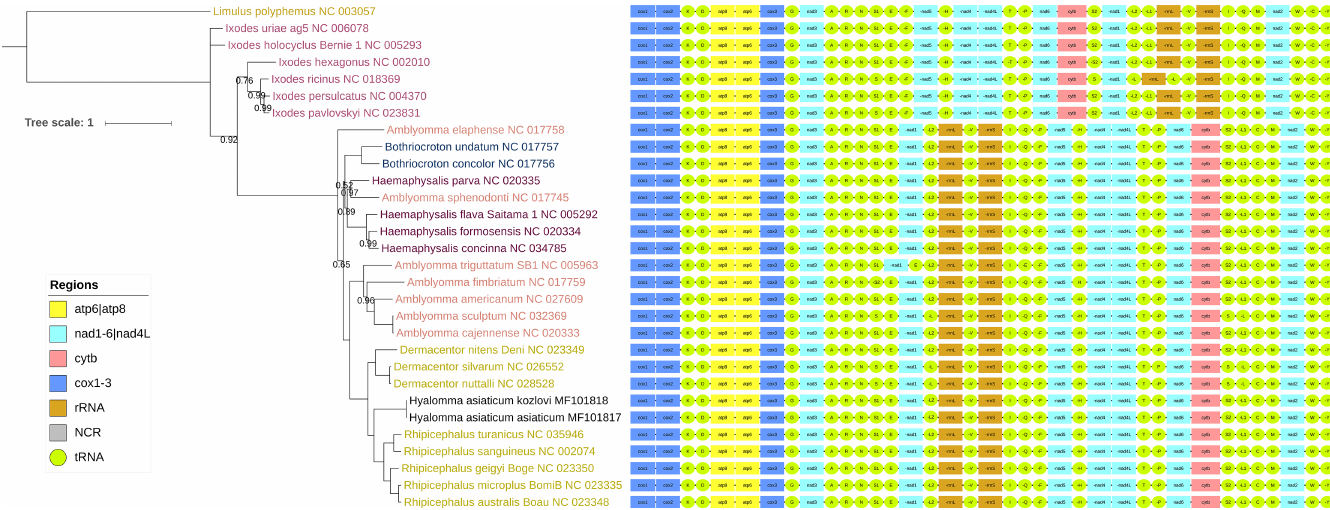
Fig 1. Mitochondrial phylogenomics and mitogenomic architecture of the Ixodidae family. Phylogenetic dendrogram was constructed using nucleotide sequences of almost complete 29 available Ixodidae mitogenomes. Heterogeneous CAT model implemented in PhyloBayes was used to conduct the Bayesian inference analysis. Limulus polyphemus is the outgroup. Scale bar corresponds to the estimated number of substitutions per site. Only the Bayesian probability values lower than 1.0 are shown next to corresponding nodes. Mitogenomic architecture is shown to the right of the corresponding sequences (the legend is incorporated in the figure). GenBank accession numbers are shown next to species names. Font colours correspond to subfamilies (according to the GenBank taxonomy), with full details available in the S1 File (supplementary data).